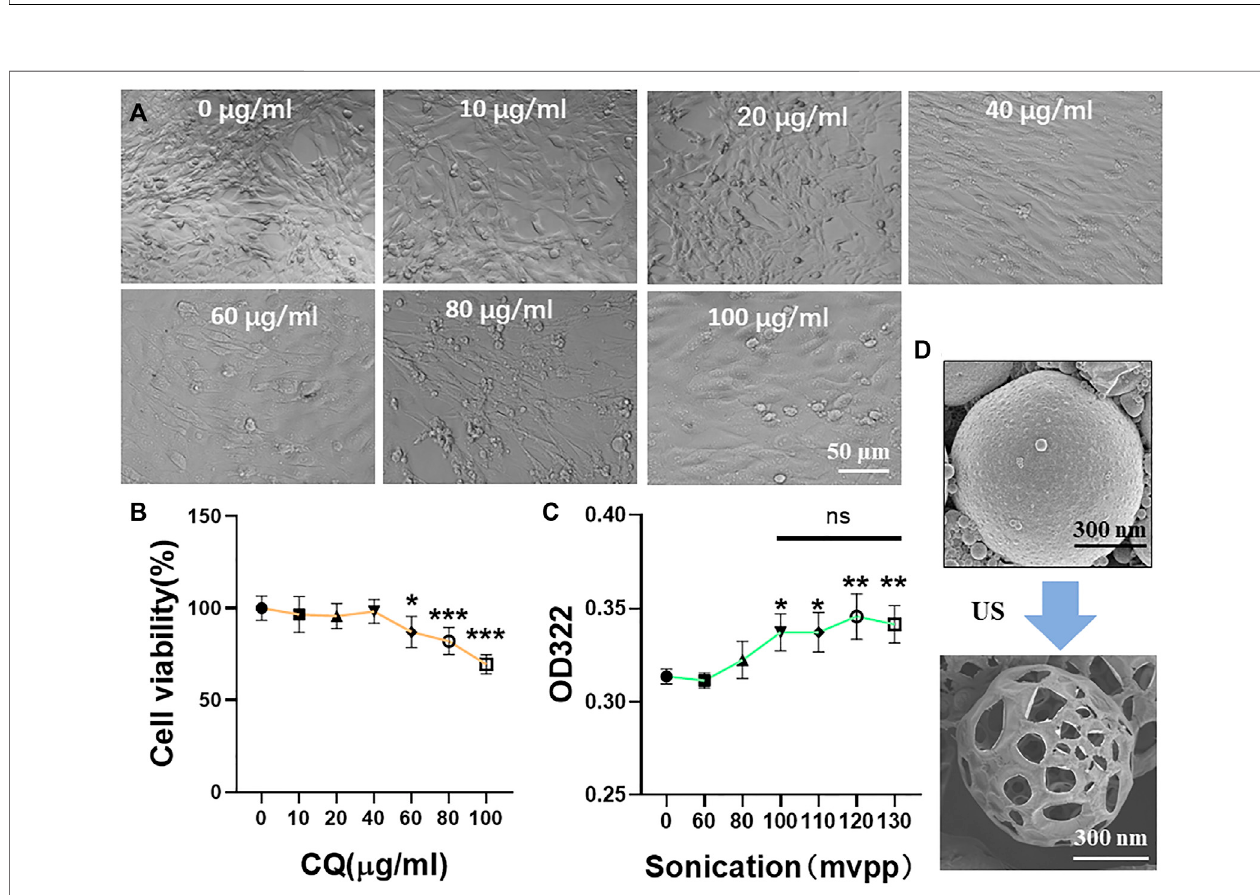
Frontiers in Pharmacology |